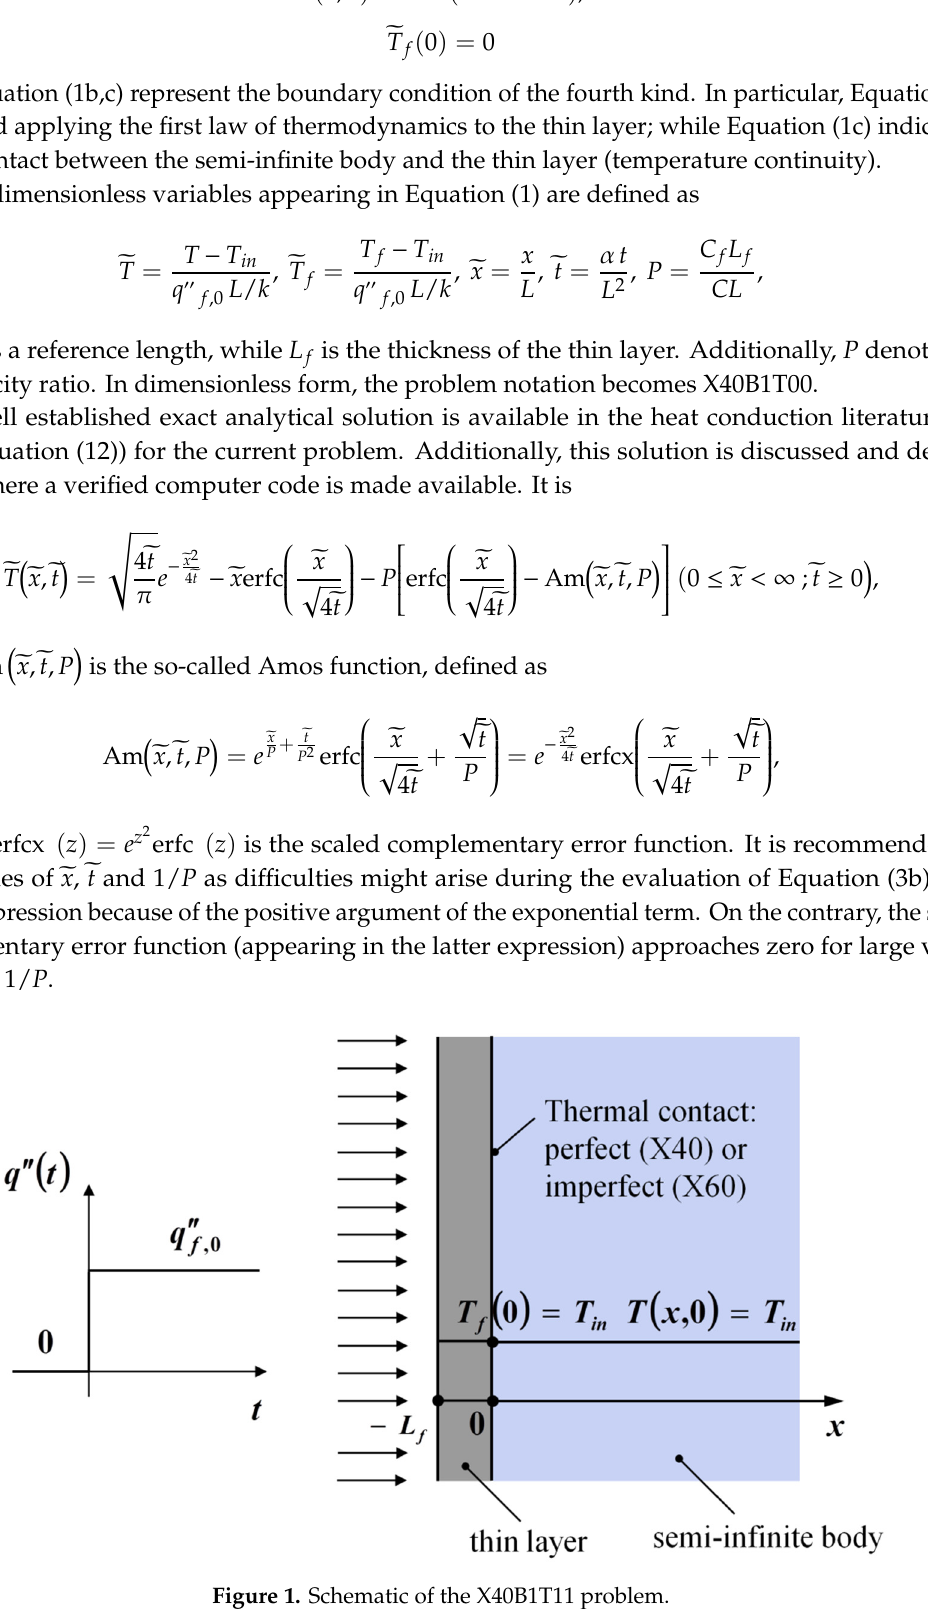
Figure 1. Schematic of the X40B1T11 problem.